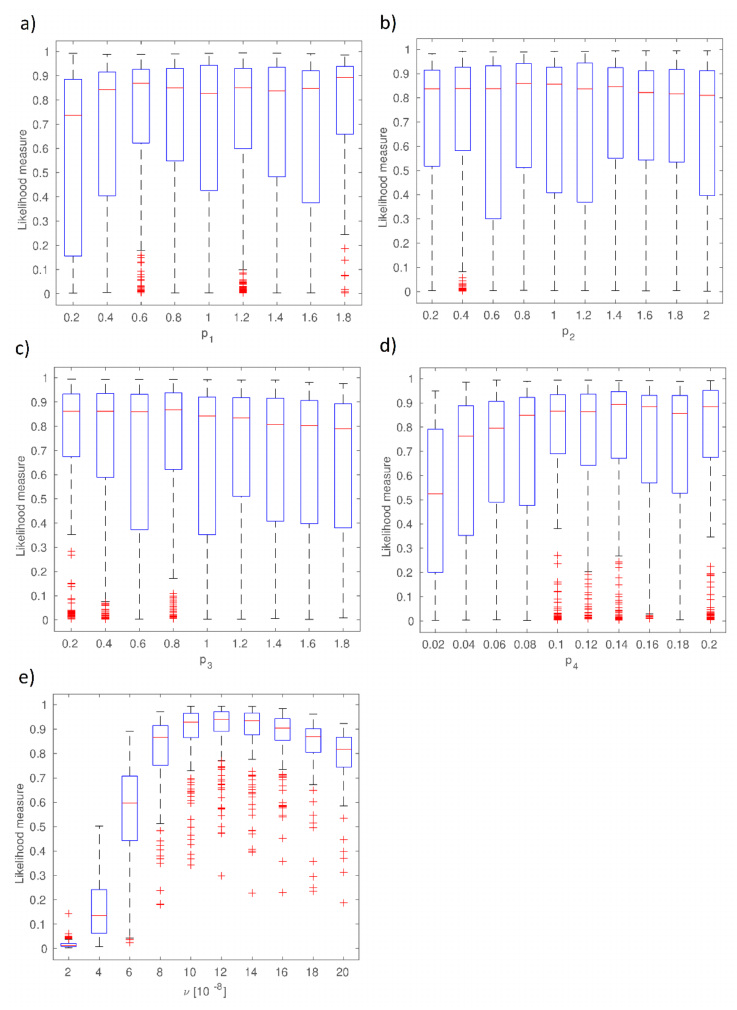
Figure 4. Reliability functions (p 1 , p 2 , p 3 , p 4 , υ ) for the calibrated parameters of Deardorff model: ( a ) reliability of C 2 parameter, ( b ) reliability of m parameter, ( c ) reliability of µ parameter, ( d ) reliability of w max , ( e ) model reliability